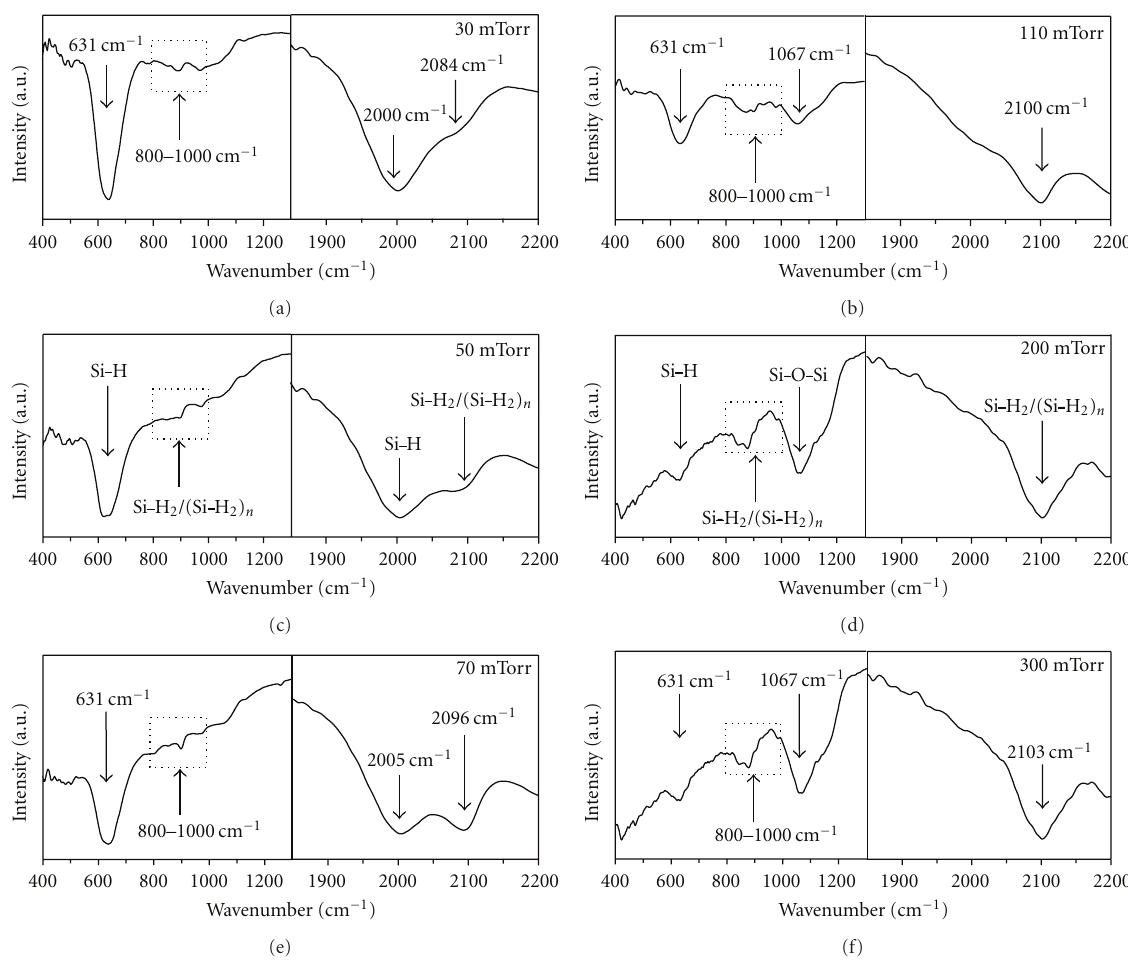
Figure 7: H-related features of the FTIR spectra for Si:H films deposited at di ff erent process pressure by hot wire method.